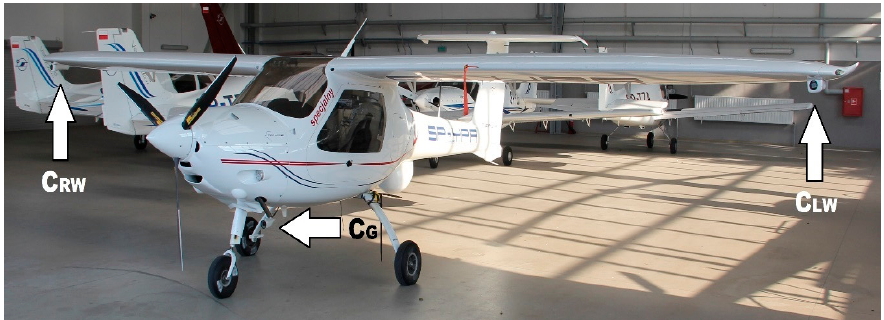
Figure 3. General view of the Czajka MP-02 airplane with an indication of the location of the observation sensors (C RW —right wing camera, C LW —left wing camera, C G —camera installed on the chassis).